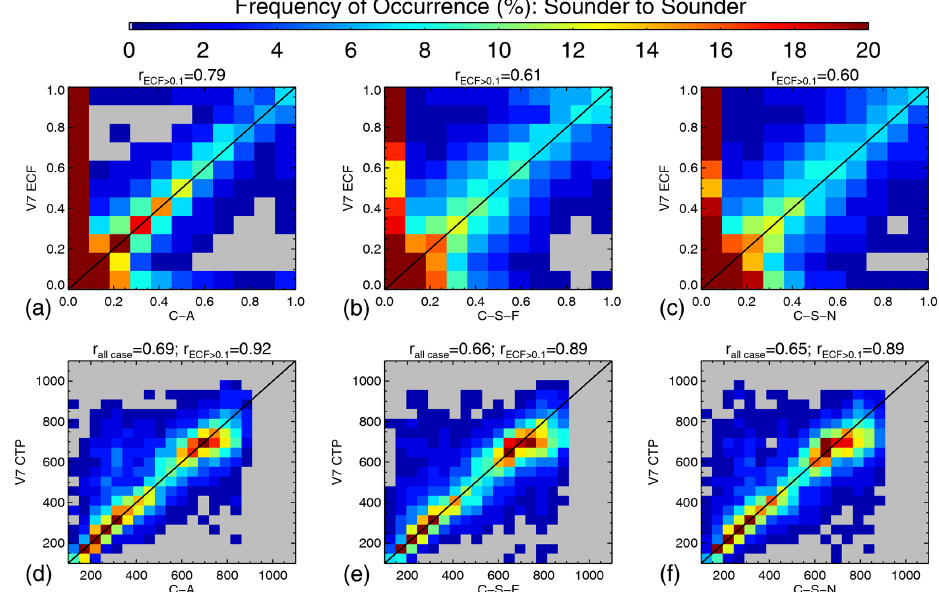
Figure 3. Comparisons of ECF (a–c) and effective CTP (d–f) derived from different sounder retrieval algorithms. Linear correlation coeffi- cients are calculated for cloud properties obtained from retrieval products indicated on the axes and are given on top of each plot. From left to right, results comparing AIRS version 7 with CLIMCAPS-Aqua (C-A), CLIMCAPS-SNPP FSR (C-S-F), and CLIMCAPS-SNPP NSR (C-S-N) are shown using joint distributions of frequency of occurrence (%). The data points located in regions poleward of 60 ◦ are excluded. Cases are included only when both retrievals in comparison ( x and y axes of the plot) report valid retrievals.